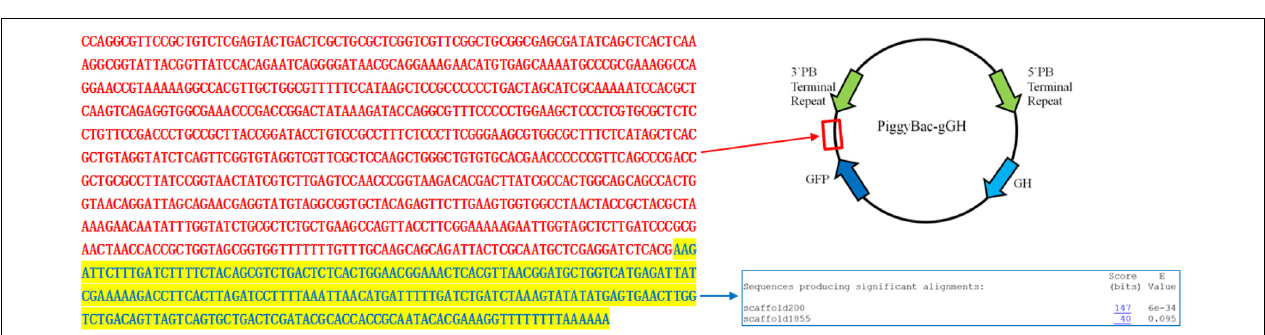
FIGURE 5 | Polymerase chain reaction (PCR) amplification of target genes using the transgenic oyster genome as template. (A) GFP gene products amplified from oyster larvae transformed with piggyBac : lane M, marker; lane 1, amplification of GFP gene using fluorescent larvae from transgenesis experiment without electroporation; lane 2, amplification of GFP gene using non-fluorescent larvae from transgenesis experiment without electroporation; lane 3, amplification of GFP gene using fluorescent oyster larvae in transgenesis experiment with electroporation; lane 4, amplification of GFP gene using non-fluorescent larvae from transgenesis experiment with electroporation; lane C, control. (B) Gene products amplified from oyster larvae transformed with piggyBac or piggyBac-gGH with electroporation: lane M, marker; lane 1, amplification of GFP gene using fluorescent larvae transfected with piggyBa c; lane 2, amplification of GFP gene using fluorescent larvae transfected with piggyBac-gGH ; lane 3, amplification of GH gene using fluorescent larvae transfected with piggyBac-gGH ; lane C, control. (C) Gene products covering partial sequences of GFP and GH genes amplified from oyster larvae transformed with piggyB ac- gGH with electroporation: lane M, marker; lanes 1 and 2, amplification of segments covering GH and GFP genes using genome walking; lane C, control.